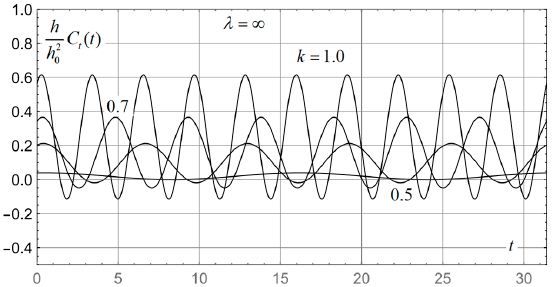
Figure 7. Instantaneous thrust (suction) force coefficient for a flat wing of infinite aspect ratio at different Strouhal numbers.